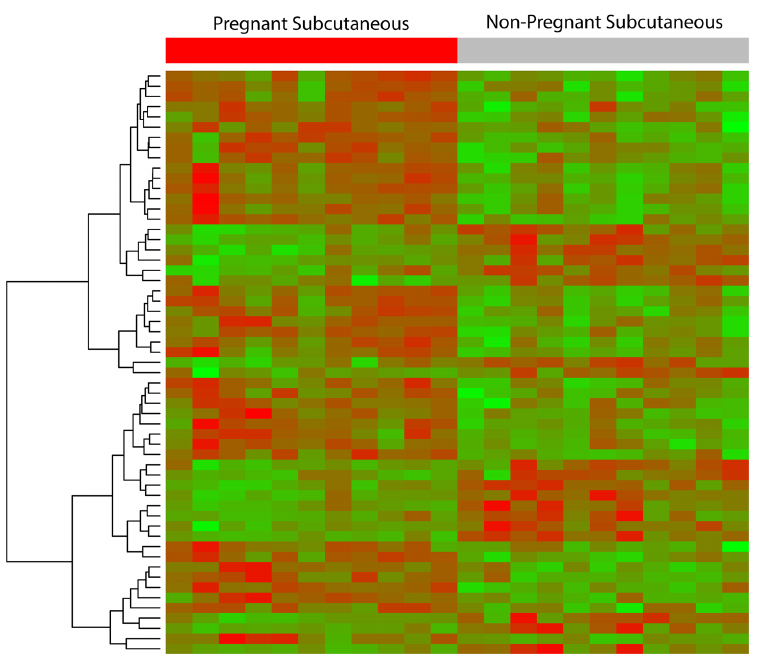
Fig 4. Heat map representing subcutaneous adipose tissue differences in gene expression of pregnant vs non-pregnant women. The heat map in Fig 4 uses a color scale to show the consistency of the expression levels within each group of samples as well as the differences between the groups that led to the positive test results.